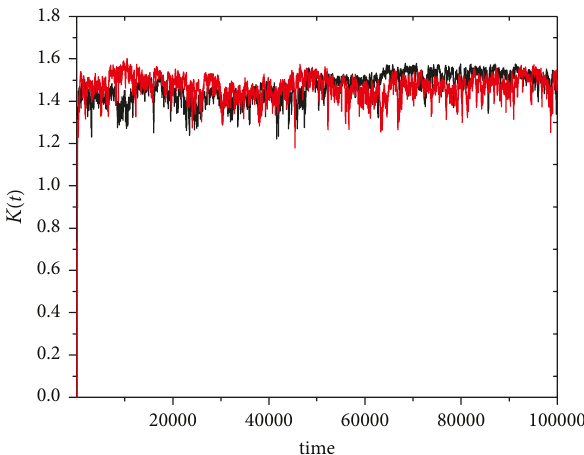
Figure 5: 𝐾(𝑡) as a function of time for the bottom-up SOTC, in the no perturbation (black line) and perturbed case (red line).